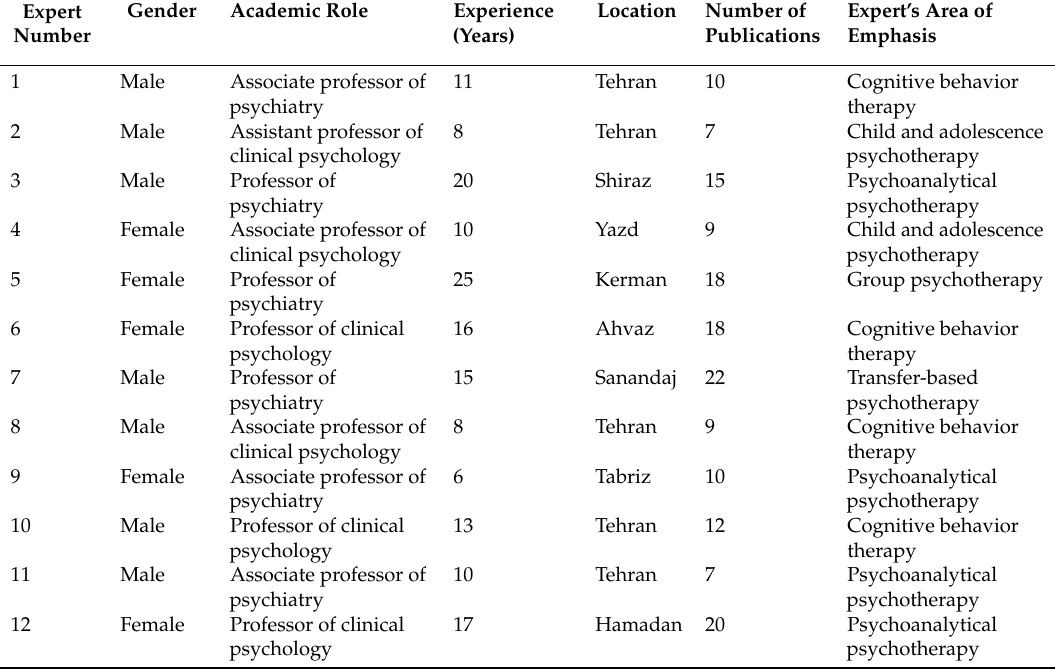
Table 1. Expert demographic characteristics from semi-structured interviews (n =